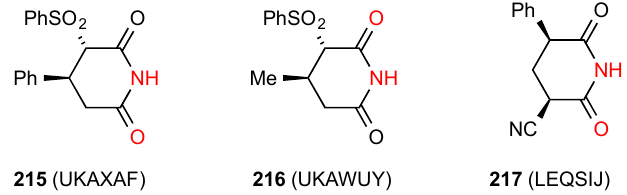
Figure 65. 3,4- and 3,5-Disubstituted glutarimides displaying patterns A and B.